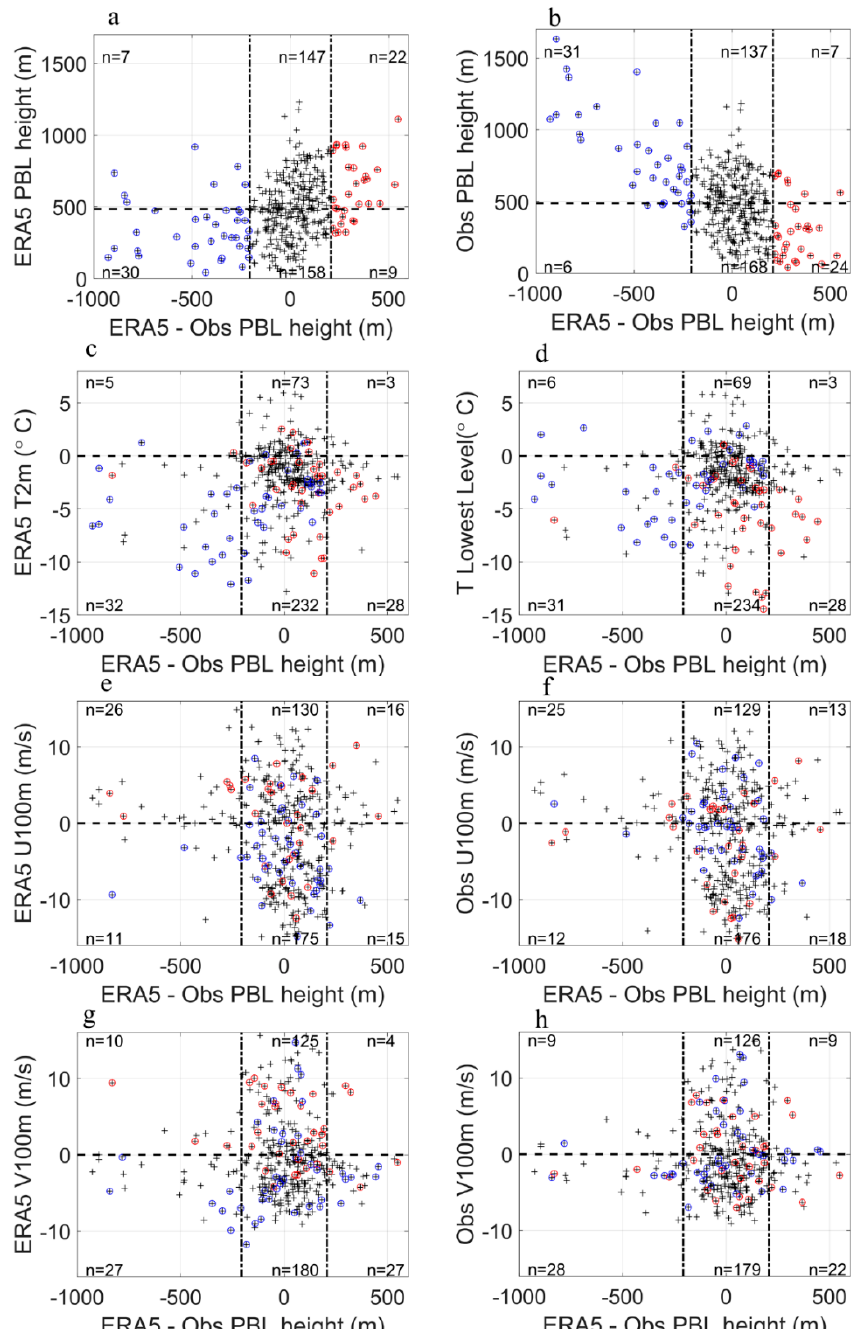
Figure 7. Relationship between ERA5 PBLH bias and ERA5 PBLH ( a ), observed PBLH ( b ), ERA5 T2m ( c ), observed lowest level temperature ( d ), ERA5 U100m ( e ), observed U100m ( f ), ERA5 V100m ( g ) and observed V100m ( h ). The black dashed line in ( a , b ) is the mean of ERA5 PBLH, while in the other sub-figures, it is zero. The black dash-dotted lines are ± 1 STD of ERA5 PBLH biases. These black lines divide the observations into six boxes. The blue circles circle these points with large negative ERA5 biases of the variable used in the ordinate, while the red circles circle the points with large positive ERA5